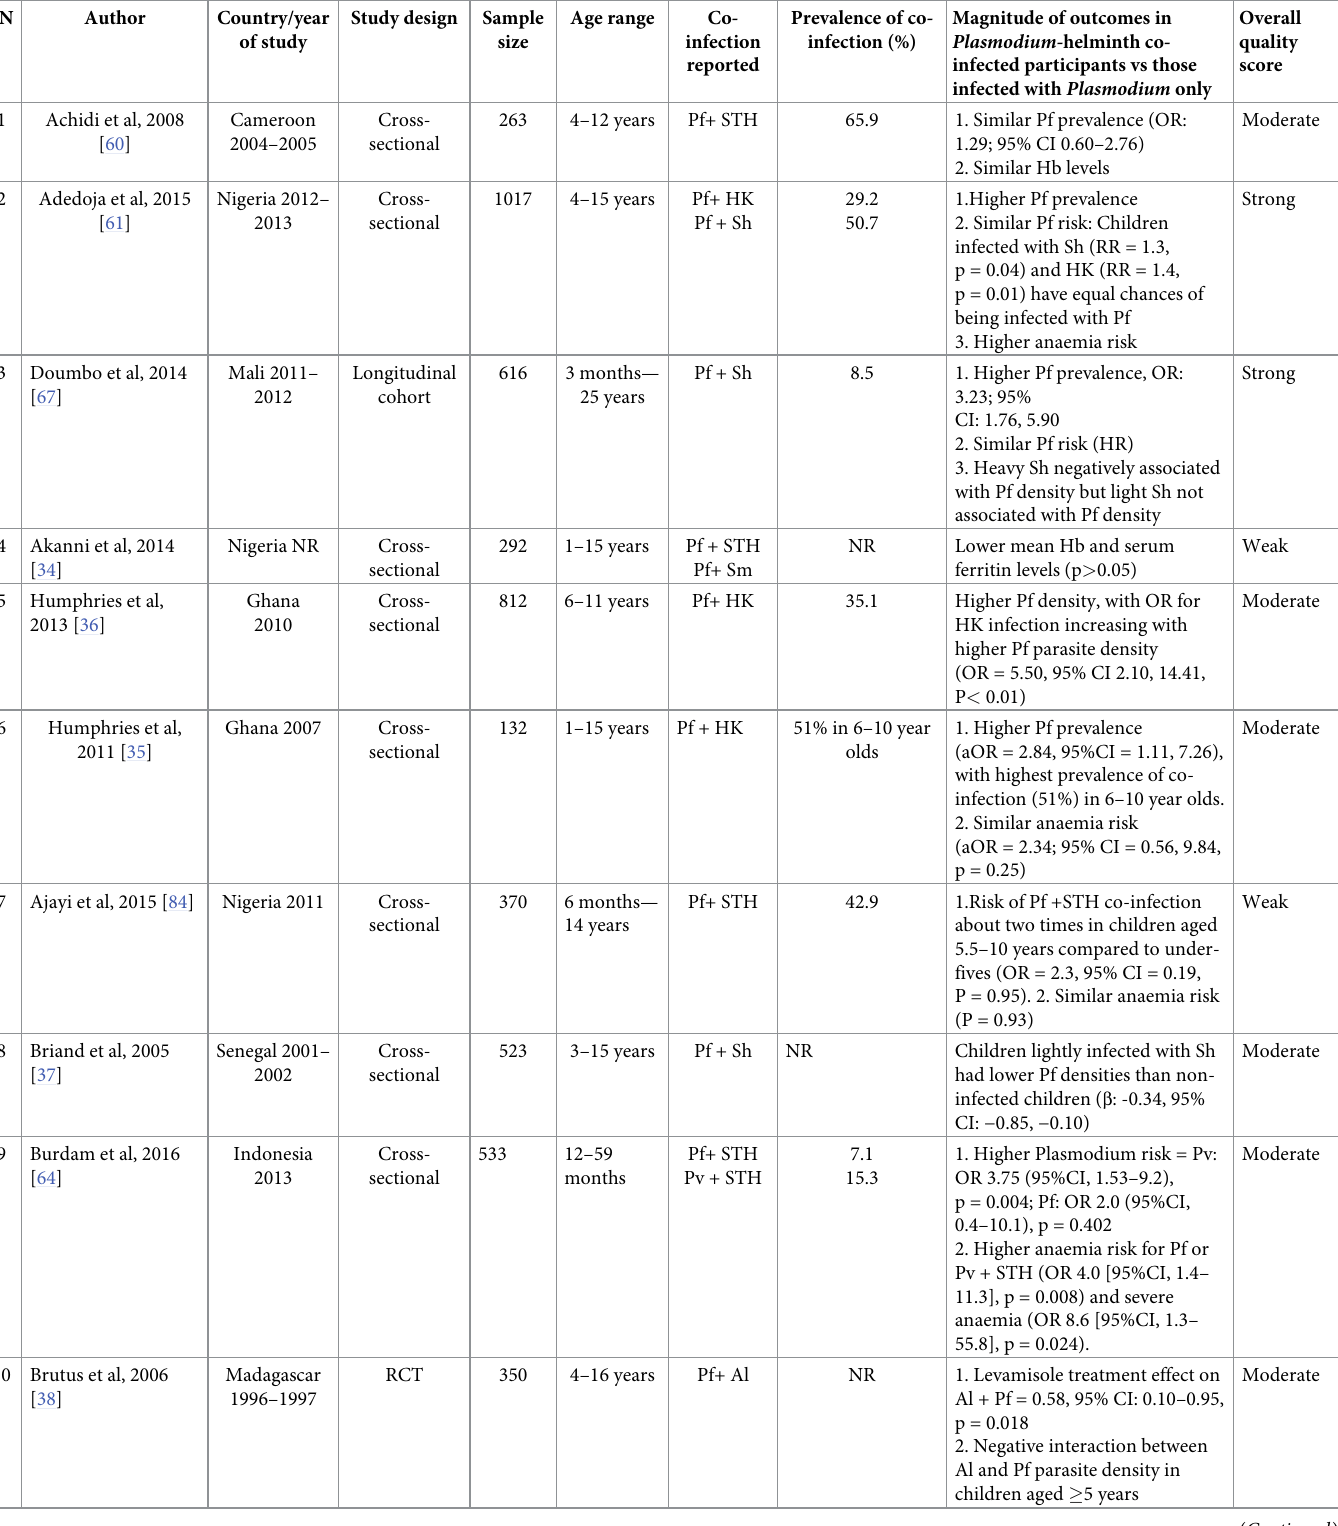
Table 1. Characteristics of included